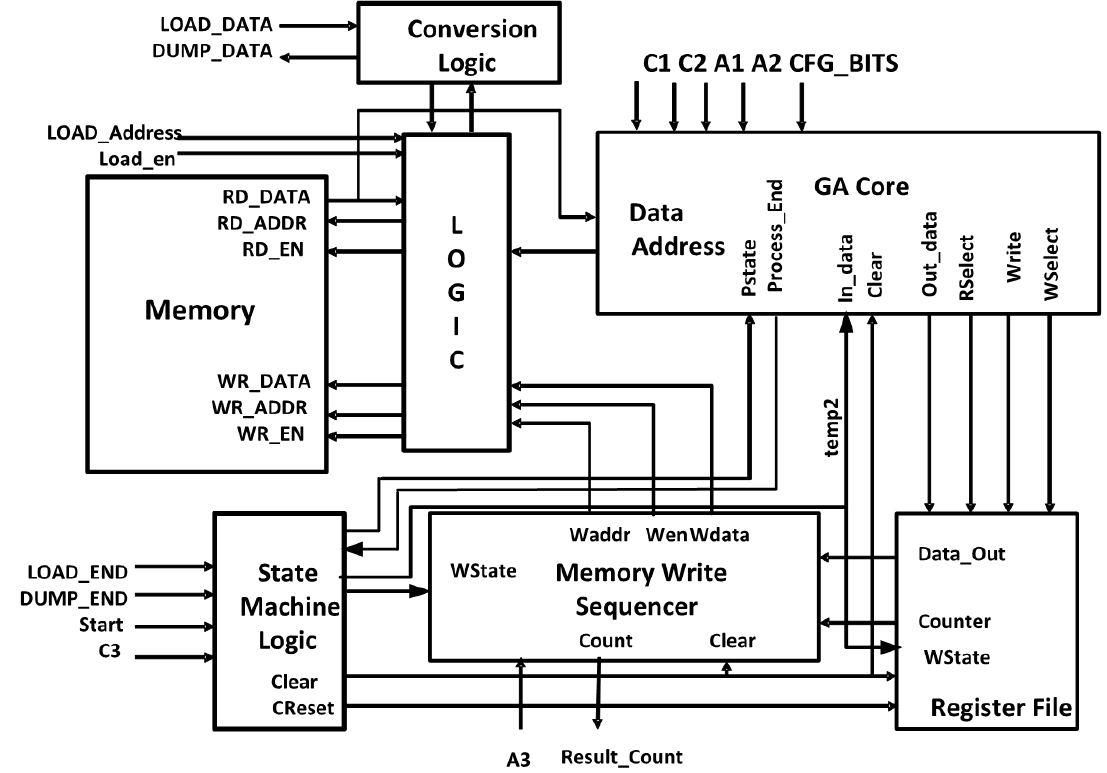
Figure 2. Rotor edge detection geometric algebra co-processor architecture with permission from the authors of ref